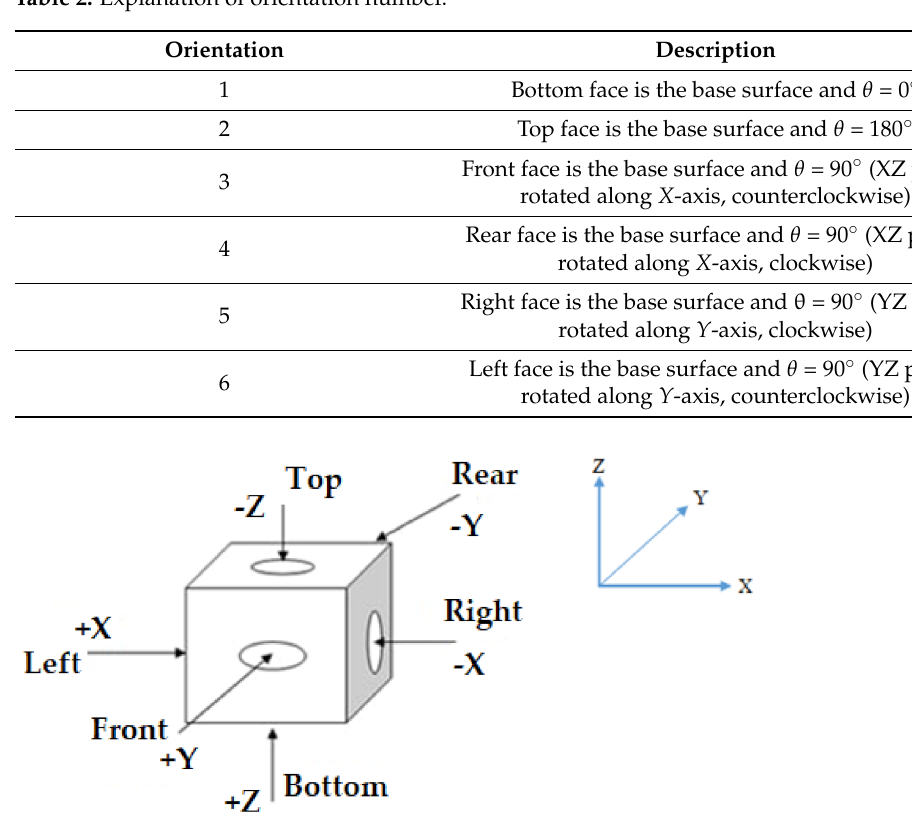
Table 2. Explanation of orientation number.